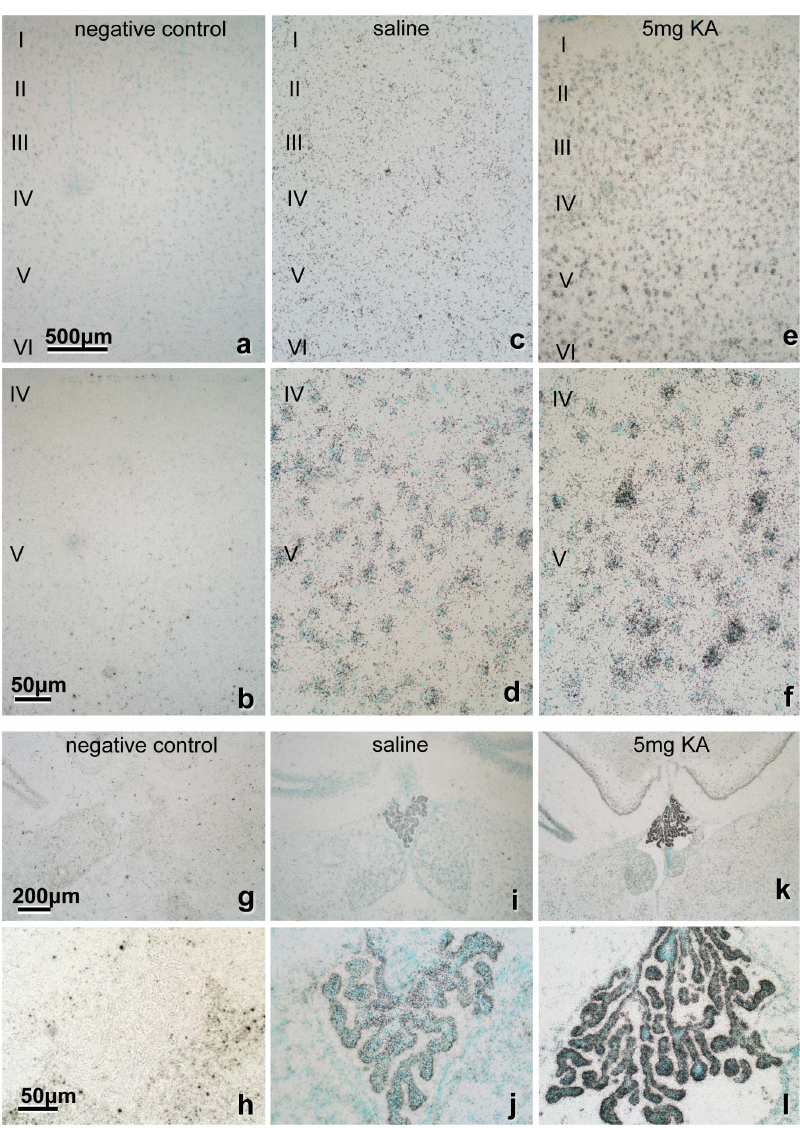
Figure 6. In situ hybridization of the cerebral cortex showing PS mRNA expression. The section stained with sense probe showed only faint hybridization signals (a, b, g, h). Compared with normal control (c, d, I, j), the signals of the antisense probe in all layers of cortex (e, f) and the choroid plexus (k, l) were significantly more intense after KA injection. Notably, the large Pyr neurons (f) and the choroid plexus (k, l) show very intense signals. Bar 5 500 m m (a, c, e), 50 m m (b, d, f, h, j, l) and 200 m m (g, i,